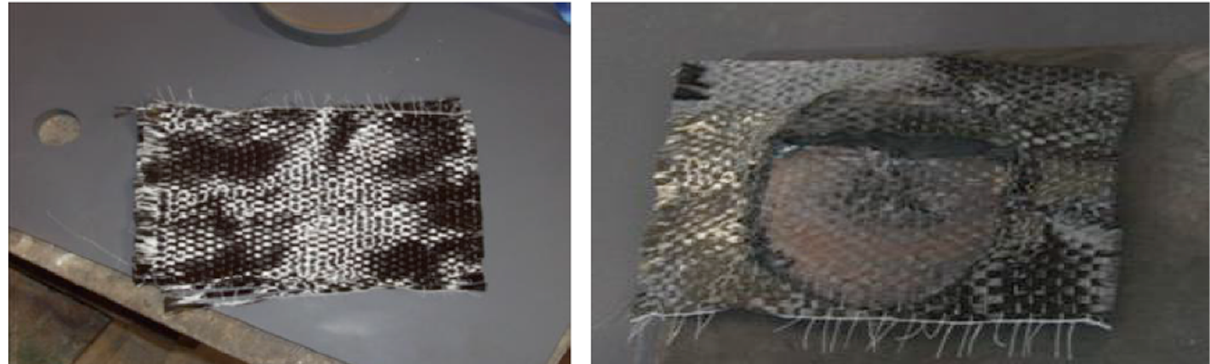
Figure 6. The upper cover plate, the lower cover plate and the slider after the experiment